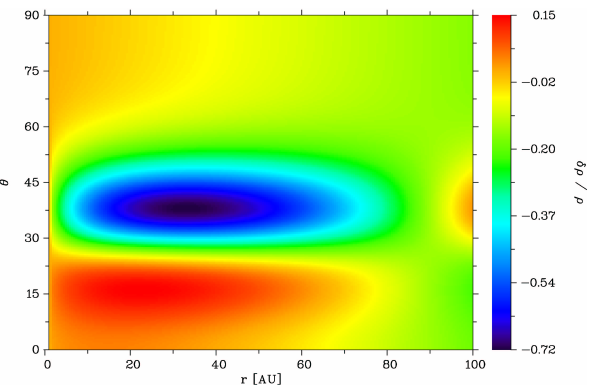
Fig. 2. The latitudinal velocity component. The solar distance is given in AU ( x − axis), the latitude in degrees ( y − axis), and the speed is colour-coded. For details see text.